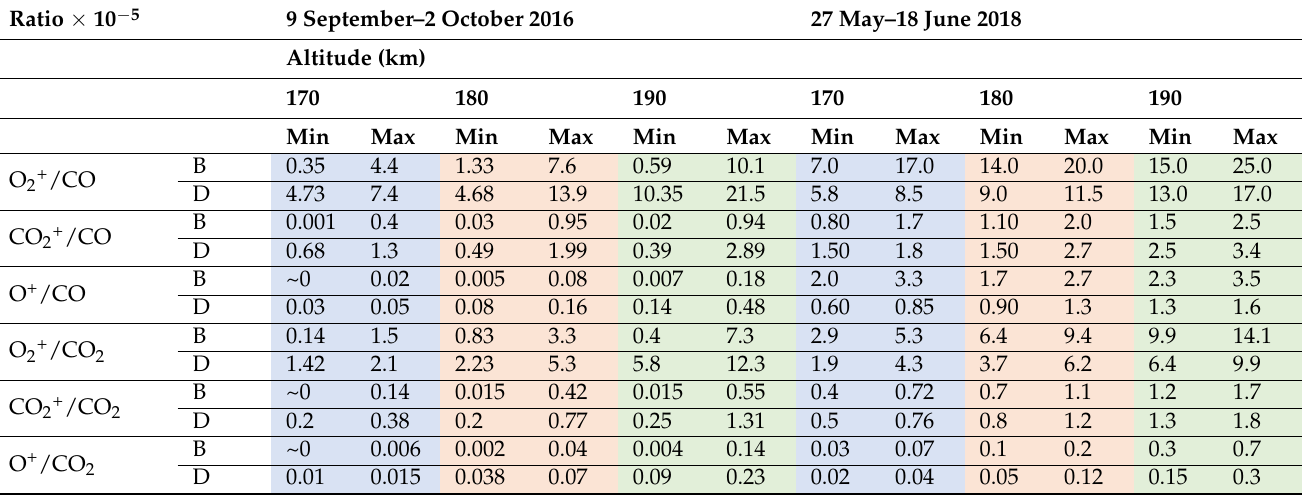
Table 1. Maximum and minimum ratios of O 2+ , CO 2+ , O + to CO and CO 2 from 9 September–